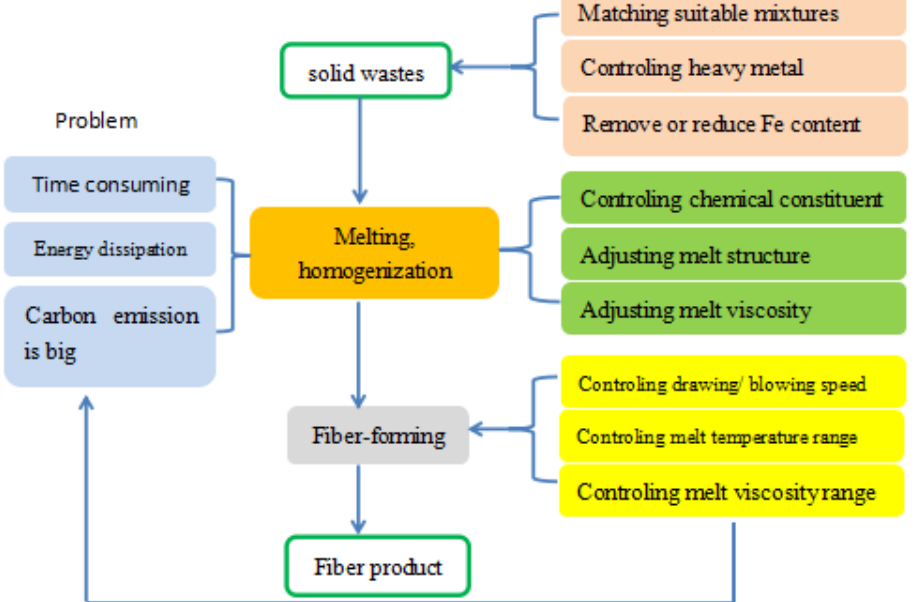
Figure 1. Production steps and control factors of the slag-based fibers.